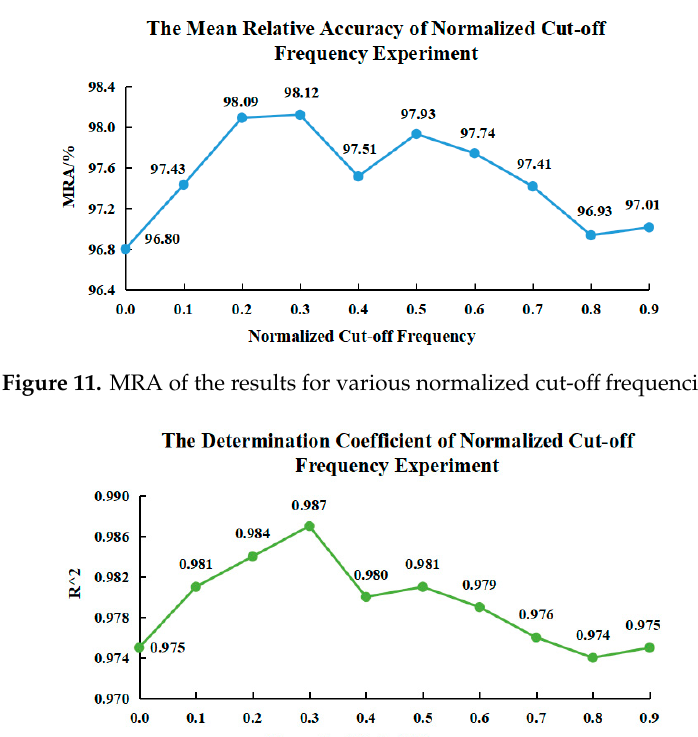
Figure 12. R 2 of the results for various normalized cut-off frequencies.